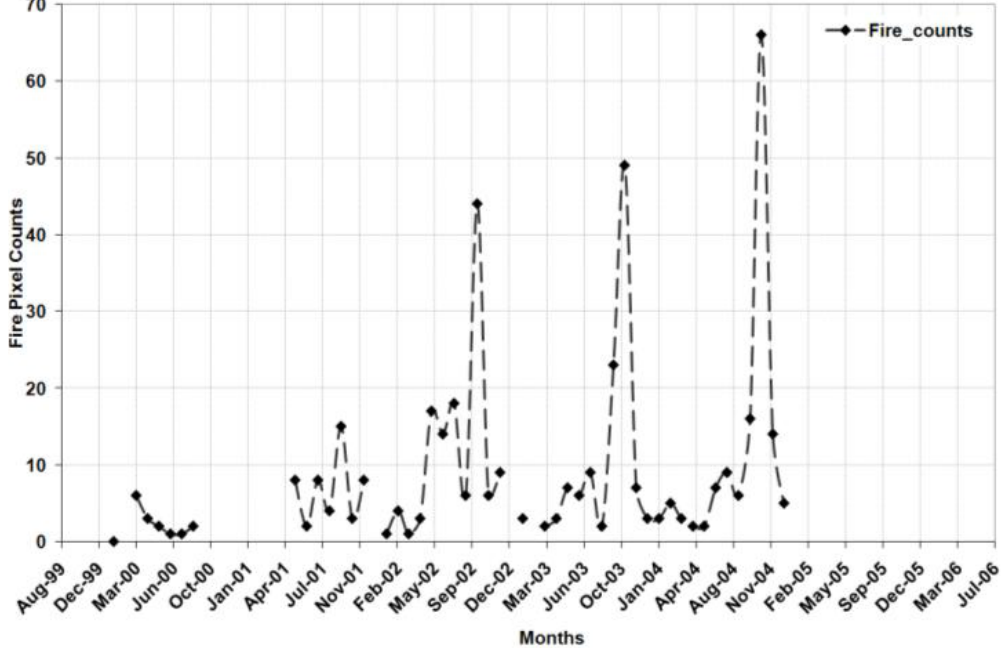
Fig. 3. Fire pixel counts in the Greater Nile Delta region as observed by MODIS on Terra, whose average local solar transit time over that location is 8:50